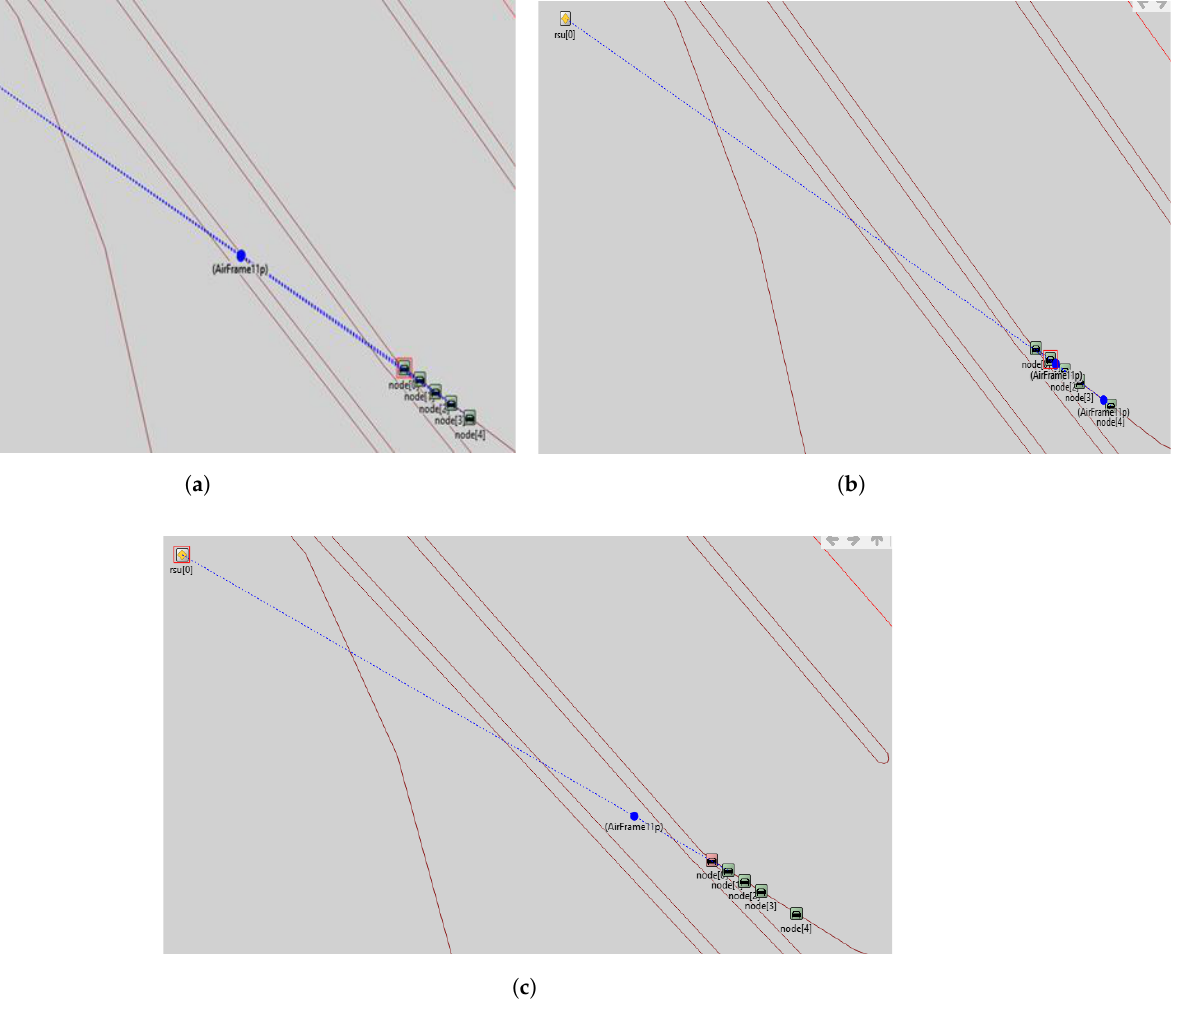
Figure 6. Communication modes. ( a ) Communication from RSU to node. ( b ) Communication from node to node. ( c ) Communication from node to